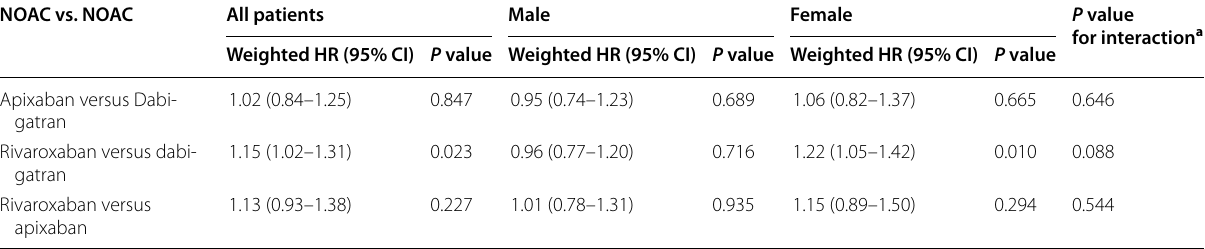
CI confidence interval, HR hazard ratio, NOAC non-vitamin K antagonist oral anticoagulant a P value for interaction between treatment effect and sex